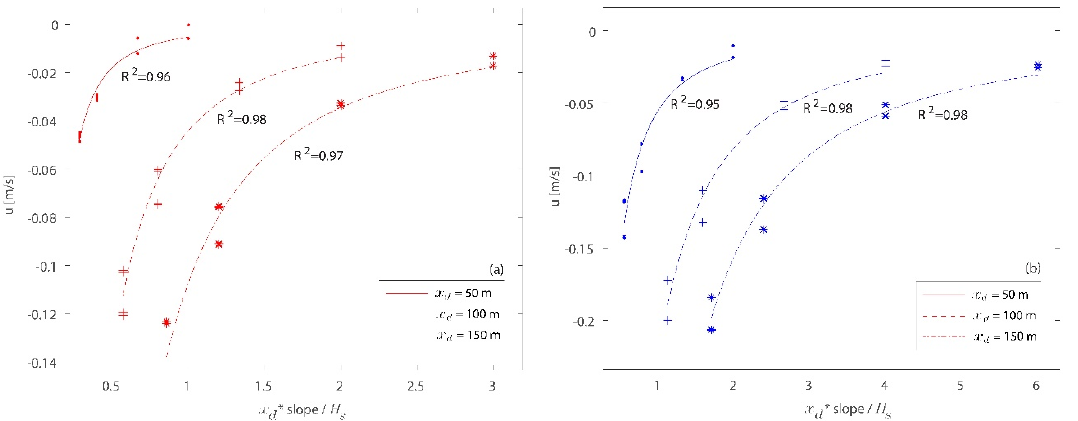
Figure 4. Mean u velocity during one tidal cycle measured at the center of section A, as function of the dimensionless variable x d * slope/ H s for all simulations with slope = 0.4% ( a ) and 0.8% ( b ).